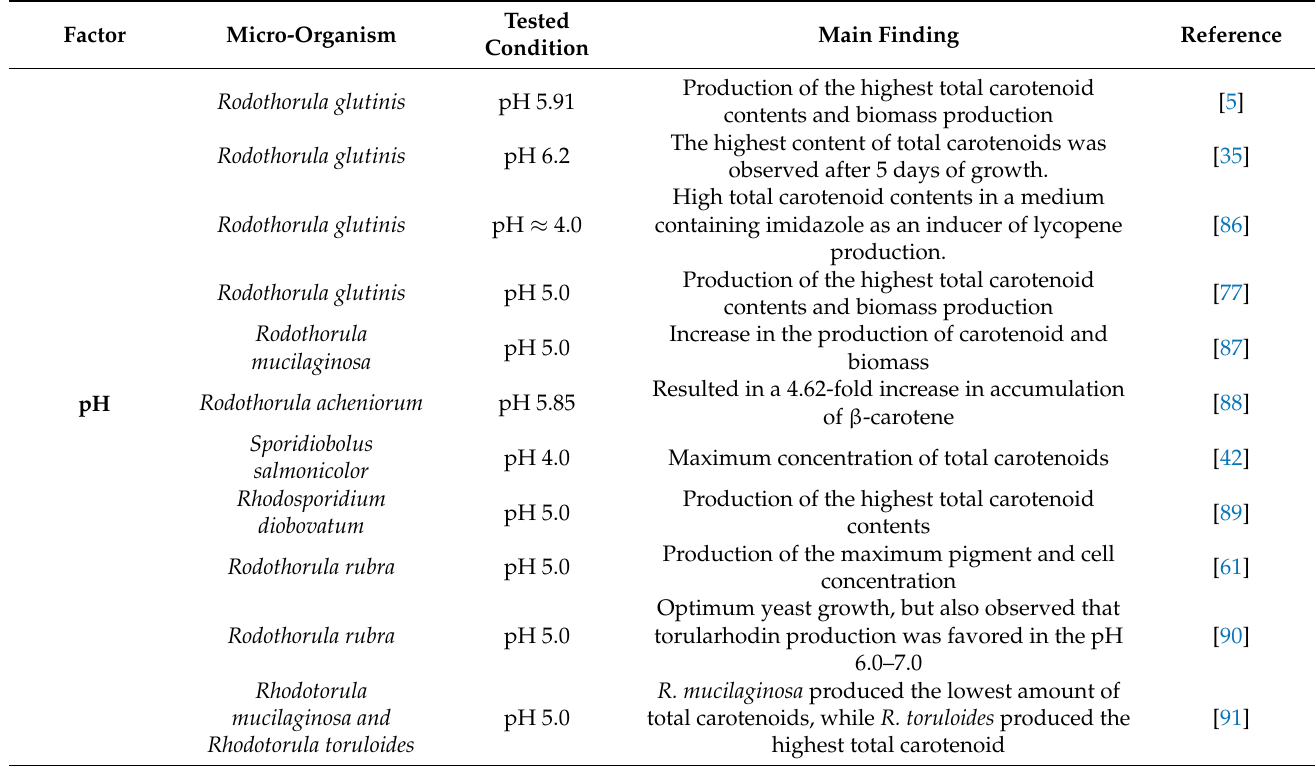
Table 4. Summarizing of factors affecting biotechnological production of